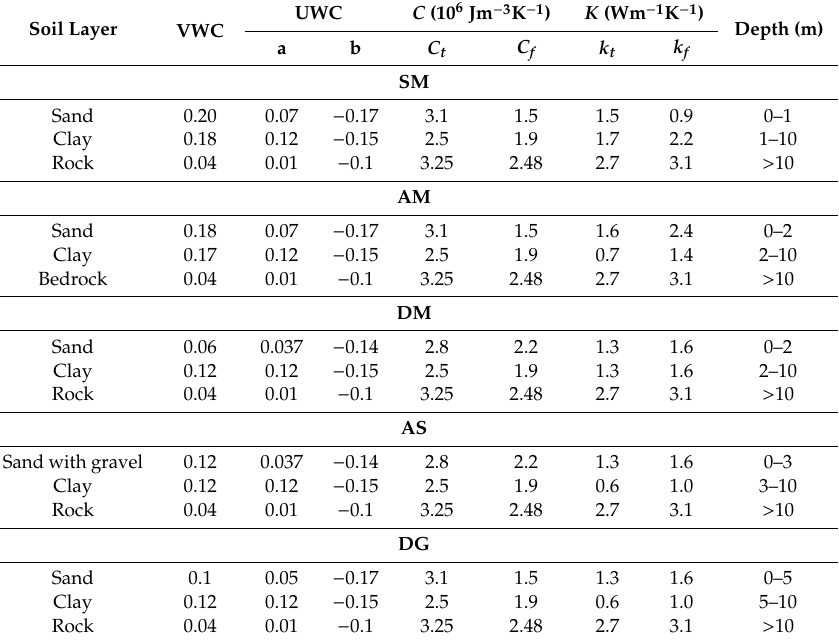
Table 1. Ground properties for each soil layer given. VWC = volumetric water content (fraction of 1); UWC = unfrozen water coe ffi cients; C t / C f = thawed / frozen volumetric heat capacities; k t / k f = thawed / frozen thermal